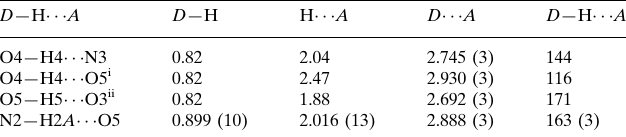
Hydrogen-bond geometry (A˚ , (cid:2)